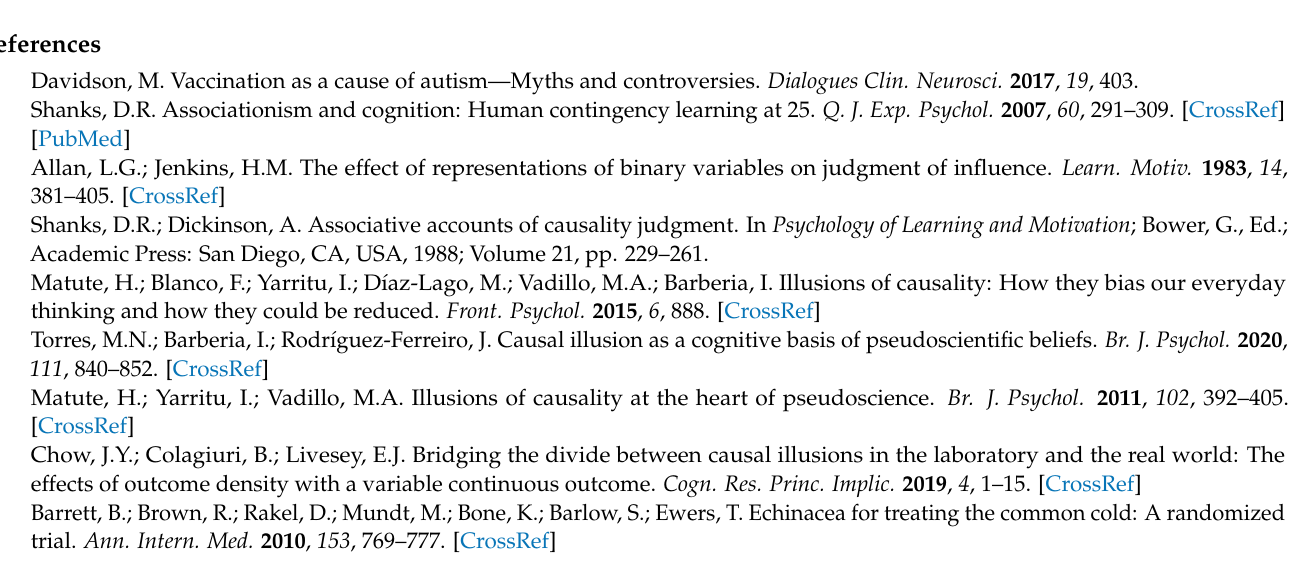
S2. Table S1: participant demographic. Analysis S1: contingency estimation and causal belief separated by question presentation. Table S2: summary statistics of hierarchical regression separated by order of question presentation. Analysis S2: contingency estimation and proximity on causal belief. Table S3: summary statistics of proximity responses. Figure S3: frequency of proximity responses by health belief. Table S4: summary statistics of the (null) interaction between contingency estimates and proximity on causal belief ratings. Analysis S3: scores on individual differences measures. Figure S4: mean scores on the revised paranormal belief scale, openness to experience and conscientiousness scale measured with the 10-item international personality item pool (IPIP), and Levenson multidimensional locus of control scale. Materials S4. surveys administered to participants. Materials S5: revised paranormal belief scale and score sheet. Materials S6: conscientiousness and openness to experience questionnaire and score sheet. Materials S7: Levenson multidimensional locus of control scale and score